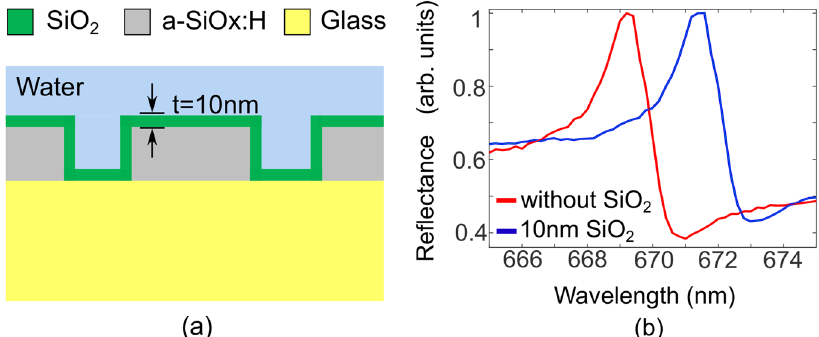
Fig. 2 Measurement of the surface sensitivity. a Schematic of the cross-section of the nanoholes array with a SiO 2 layer with a thickness t = 10 nm. b Experimental spectra of the bare nanoholes array (red curve) and with the SiO 2 layer (blue curve) for TM